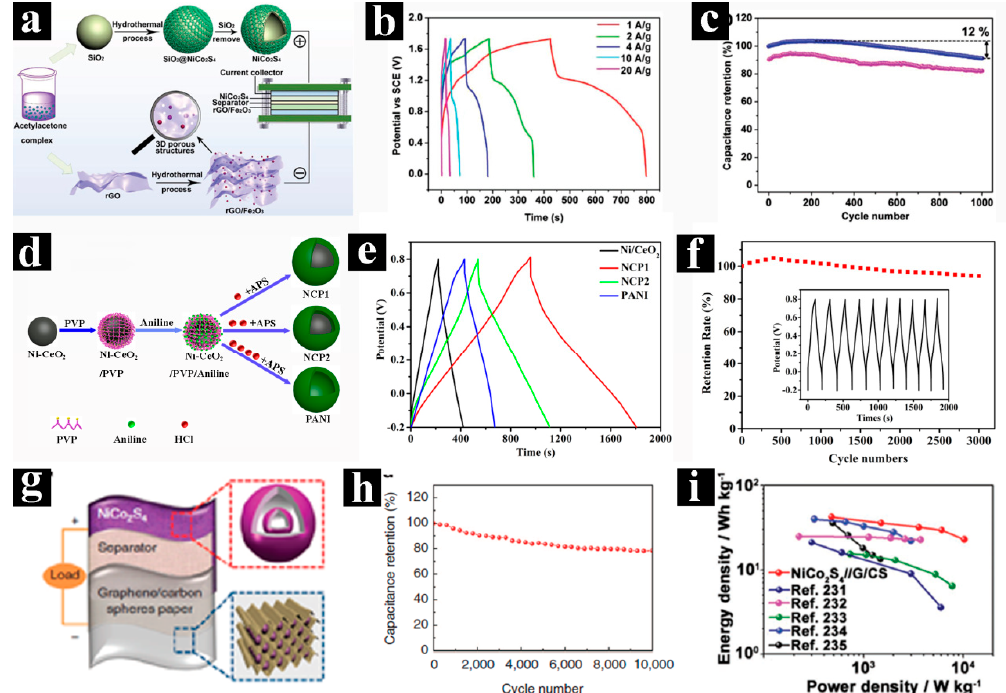
Figure 14. Schematic demonstration of hollow, core-shell, and double-shell spheres and their supercapacitors (SCs) performance: ( a ) Schematic illustration of the synthesis of NiCo 2 S 4 hollow spheres, ( b ) galvanostatic charge and discharge (GCD) curves of the NiCo 2 S 4 // rGO / Fe 2 O 3 device at various current densities, and ( c ) cycling performance of NiCo 2 S 4 // rGO / Fe 2 O 3 device at the current density of 2.0 A g − 1 . ( d ) Schematic illustration of the synthesis of core–shelled Ni-CeO 2 @PANI nanospheres (NCP1), yolk–shelled Ni-CeO 2 @PANI nanospheres (NCP2), and polyaniline (PANI), ( e ) GCD curves of the Ni-CeO 2 , core-shelled NCP1, yolk-shelled NCP2, and PANI hollow nanospheres at a current density of 1 A g − 1 , and ( f ) cycle stability of core-shelled NCP1 nanospheres at a high current density of 10 A g − 1 , inset shows the last 10 cycles of GCD curves. ( g ) Schematic illustration of the asymmetric supercapacitor (ASC) device based on the NiCo 2 S 4 double-shelled hollow spheres (DSHSs), ( h ) cycling stability at a current density of 5 A g − 1 and ( i ) the corresponding Ragone plot of the NiCo 2 S 4 DSHSs ASC. Pictures ( a ), ( b ), and ( c ) were reprinted with permission from Reference [74]. Copyright Wiley, 2018. Pictures ( d ), ( e ), and ( f ) were reprinted with permission from Reference [90]. Copyright Elsevier, 2018. Pictures ( g ), ( h ), and ( i ) were reprinted with permission from Reference [121]. Copyright Springer, 2015.